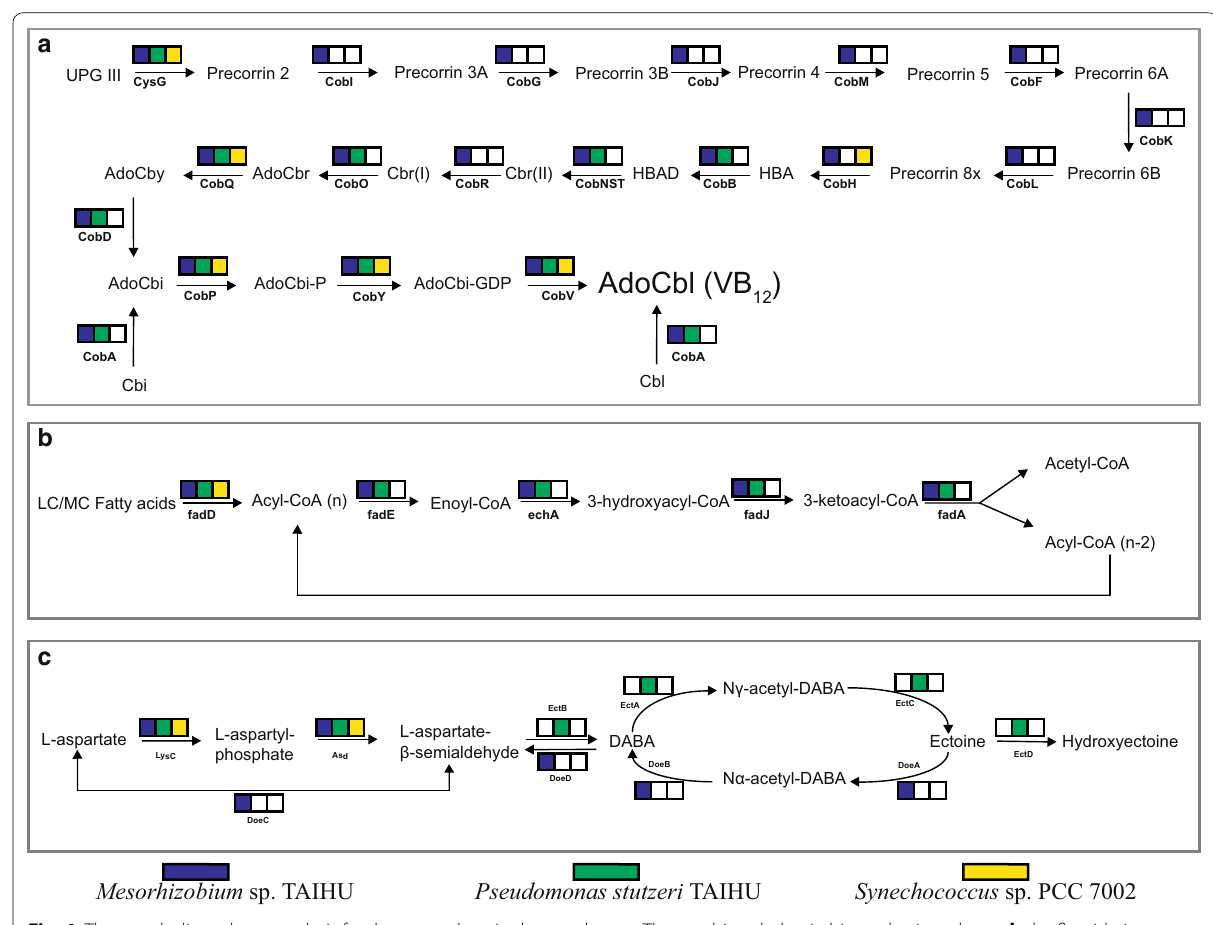
Fig. 4 The metabolic pathway analysis for three members in the coculture. a The aerobic cobalamin biosynthesis pathway; b the β-oxidation pathway; c the ectoine biosynthesis and degration pathway. The color box indicates that the individual in the coculture carries the gene encoding the enzyme involved in the pathway, whereas an empty box (white) indicates the absence of the corresponding gene. The genes in Synechococcus sp. PCC 7002, Mesorhizobium sp. TAIHU and Pseudomonas stutzeri TAIHU are shown in yellow, blue and green, respectively. The abbreviations of the metabolites and enzymes used in the figure refer to the reference pathway (map00860, map00071, map00260) in KEGG database and the paper by Swither et al.